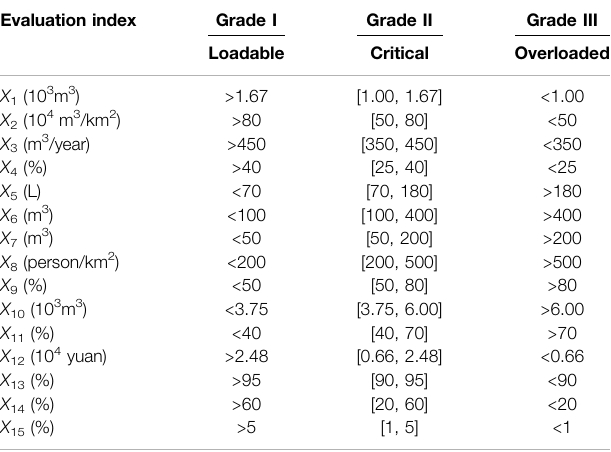
TABLE 1 | Grade criteria for evaluating the carrying capacity of water resources in Anhui